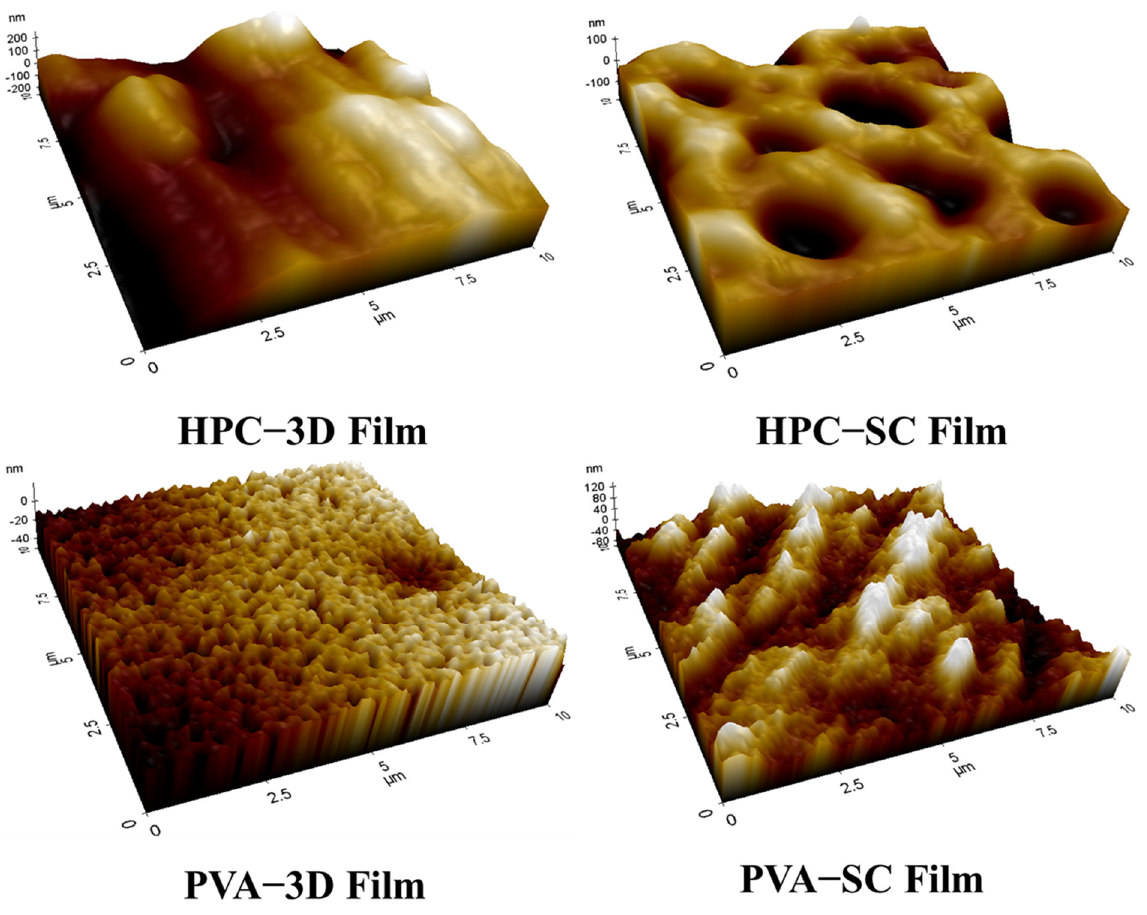
Figure 7. Atomic force microscopy topography of the 3D-printed (3D) films and solvent-cast (SC) films.